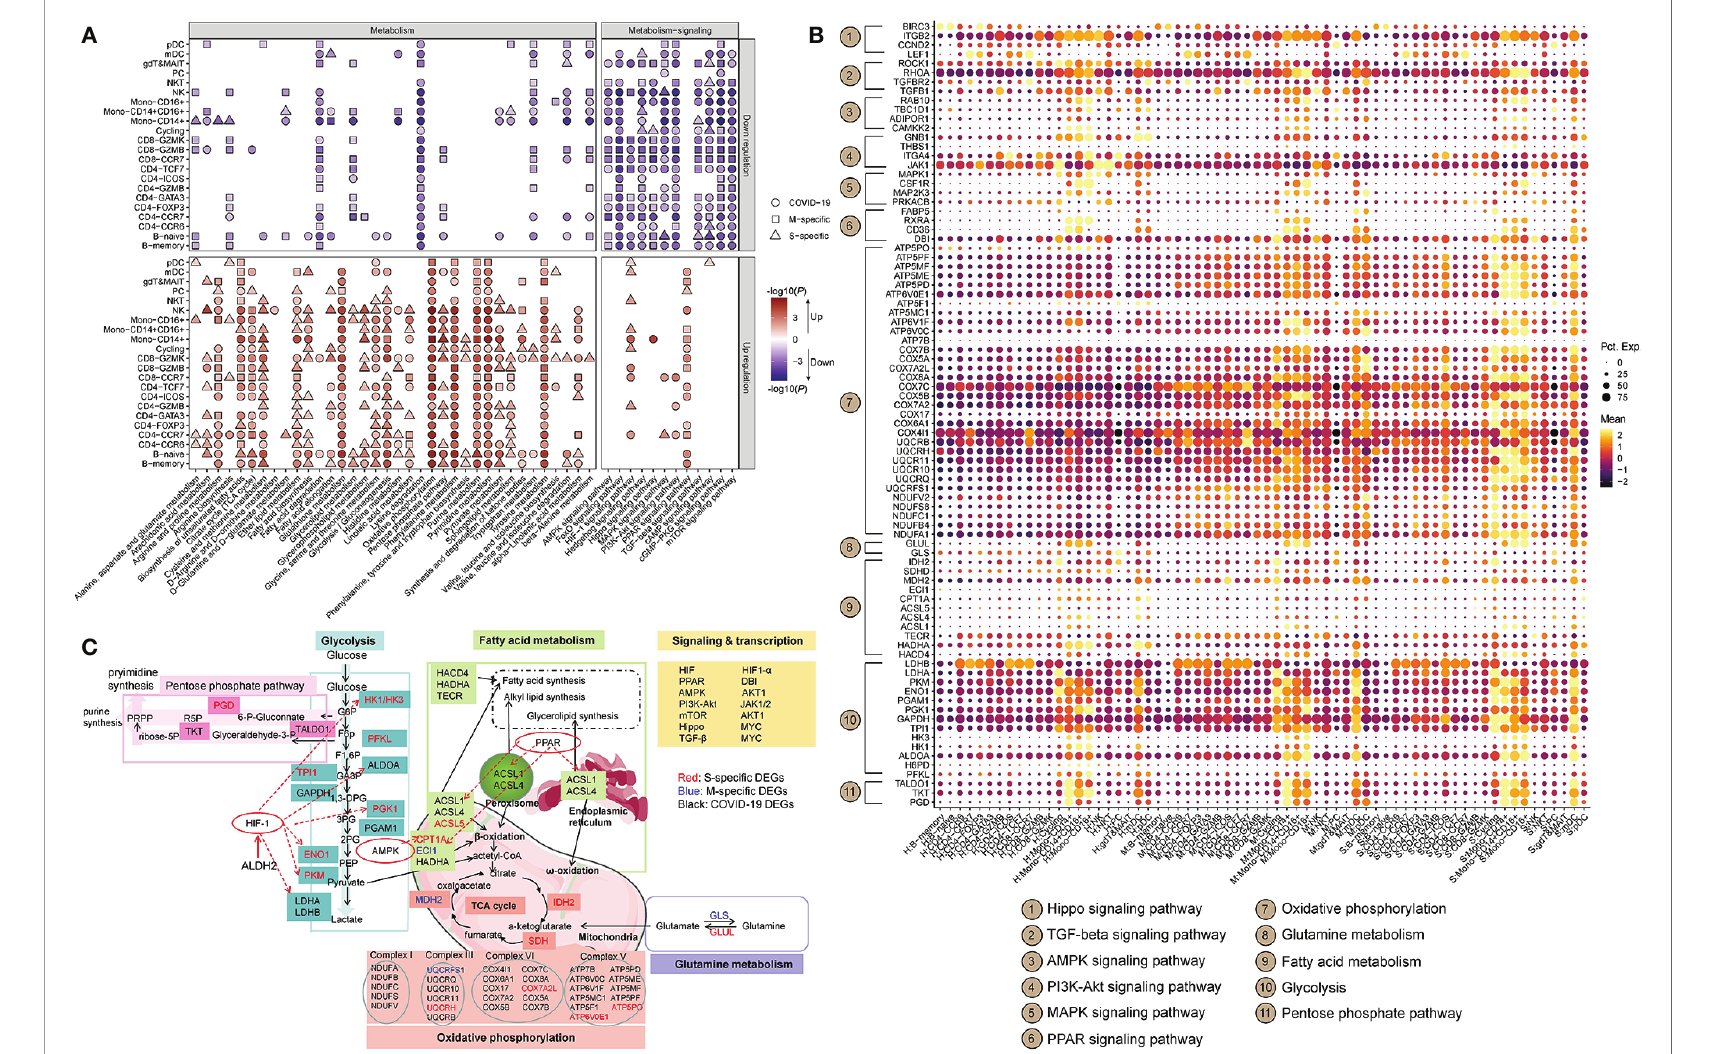
FIGURE 2 | Metabolic transcriptome rewiring of immune cells in COVID-19 patients. (A) The signi fi cantly altered metabolic processes (left panel) and metabolism-related signaling (right panel) KEGG pathways in each cell cluster in COVID-19 patients (Student ’ s t-test; P < 0.01). M-speci fi c: the unique KEGG pathways that were signi fi cantly altered in patients with mild disease compared to healthy controls. S-speci fi c: the unique KEGG pathways that were signi fi cantly altered in patients with severe disease compared to healthy controls. COVID-19: KEGG pathways that were signi fi cantly altered in patients with mild and severe disease compared to healthy controls. (B) The dot plot of selected DEGs that are involved in metabolic processes or metabolism-related signaling KEGG pathways. “ Mean ” indicates the average gene expression level. “ Pct.Exp. ” indicates the percentage of cells expressing the corresponding genes. (C) Global maps of metabolic rewiring in COVID-19 patients according to the DEGs and the KEGG pathways in which they are involved. The S-speci fi c DEGs are shown in red, the M-speci fi c DEGs in blue, and the DEGs in COVID-19 patients in